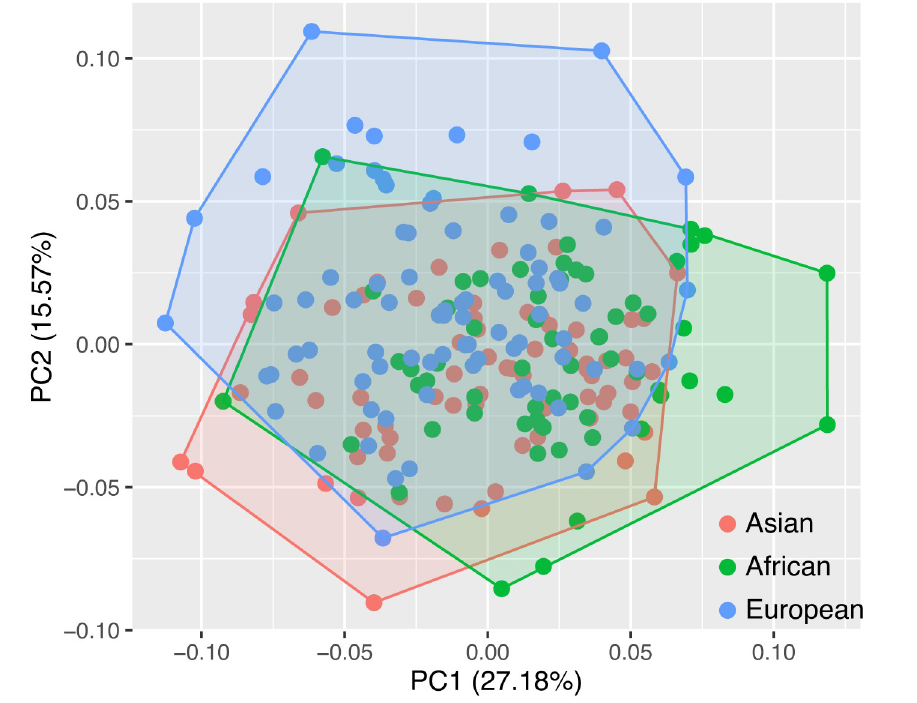
Fig 4. Scatterplot of the first two principal components.